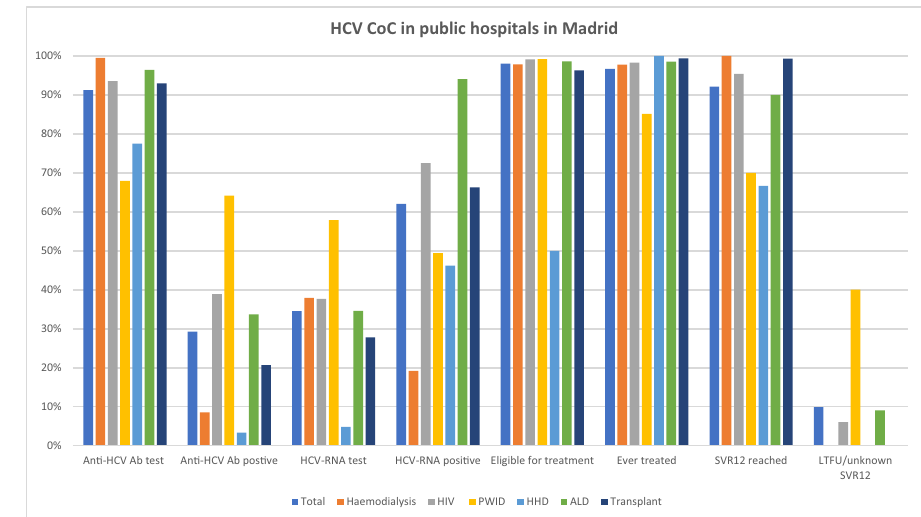
Fig. 1 Analysis of the HCV CoC in public hospitals in Madrid. Pre-dialysis patients were omitted, given the high proportion of anti-HCV Ab and HCV – RNA testing (100.0%), out of those anti-HCV Ab positive for the latter, and low proportion of HCV – RNA-positive patients (0.0%). Category ‘ Ever treated ’ includes patients with ongoing and completed treatment. Denominator for ‘ Anti-HCV Ab test ’ , ‘ Anti-HCV Ab positive ’ and ‘ HCV-RNA test ’ is the total n of patients of each corresponding group; ‘ HCV-RNA positive ’ is the n of patients who were tested for HCV-RNA of each corresponding group; ‘ Eligible for treatment ’ is the n of patients who tested positive for HCV – RNA of each corresponding group; ‘ Ever treated ’ is the n of patients who were eligible for treatment of each corresponding group; ‘ SVR12 reached ’ is the n of patients who completed treatment of each corresponding group; ‘ LTFU/unknown SVR12 ’ is the n of patients who were ever treated of each corresponding group. Anti-HCV Ab HCV antibody, ALD advanced liver disease, CoC cascade of care, HCV hepatitis C virus, HHD hereditary haematological diseases, LTFU lost to follow-up, PWID people who inject drugs, SVR12 sustained virological response 12 weeks post